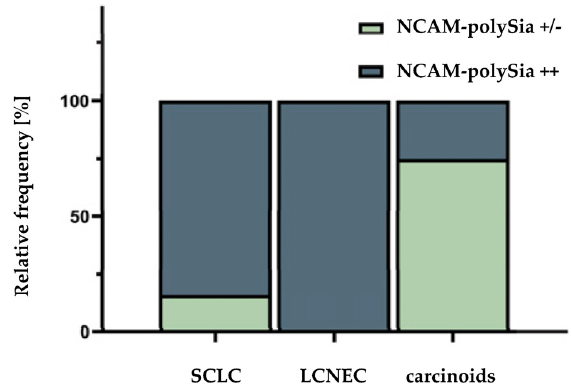
Figure 1. Relationship between the polySia-NCAM expression and entity. Large cell neuroendocrine carcinomas of the lung: LCNEC, small cell lung cancers: SCLC. Within the group of SCLCs, a majority (84.2%) showed strong polySia-NCAM expression. In the group of LCNECs, all patients (100%) were strongly polySia-NCAM positive. In the carcinoid subtype, only 25% of patients showed strong polySia-NCAM expression. An χ 2-test was performed to analyze a possible correlation between histology and polySia-NCAM expression ( p = 0.0140).